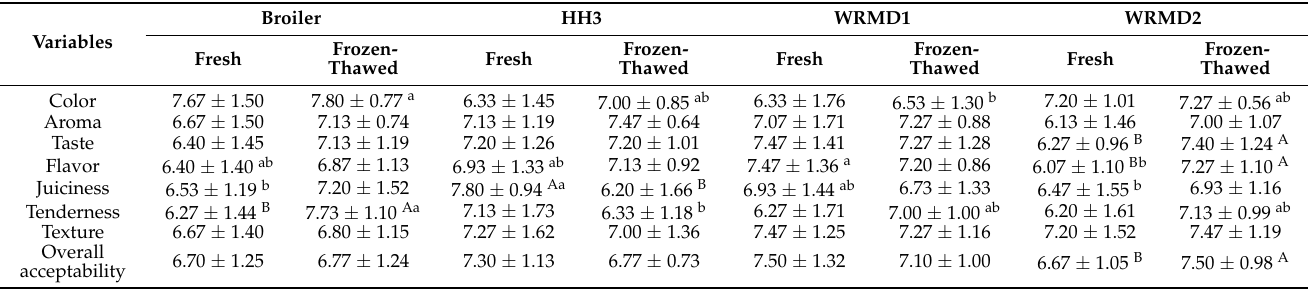
Table 7. Comparison of sensory characteristics of fresh and Frozen-Thawed chicken meats from Korean native chickens and